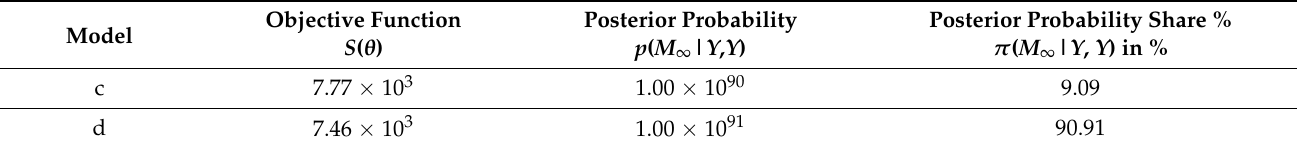
Table 8. Modeling results from Bayesian statistics for the case of heterogeneous liquid-liquid phase system. Model